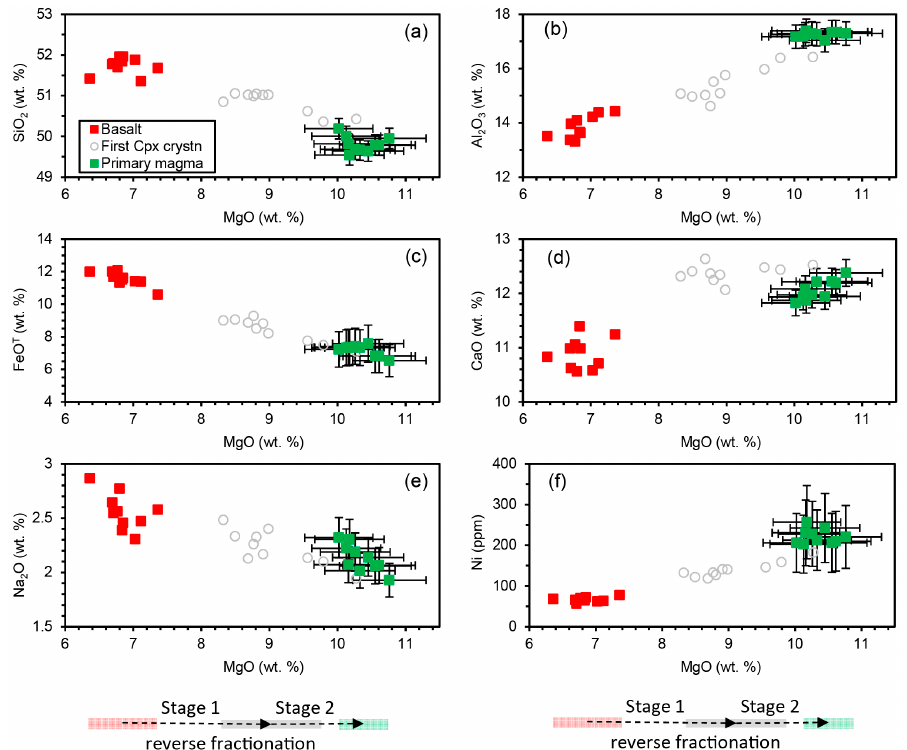
Figure 7. Bivariate plots showing the variation of the major oxides ( a – e ) and Ni with MgO ( f ) for the Rajmahal Group I basalts (corrected melt compositions) and their primary magmas. The compositions of melt in which clinopyroxene first crystallizes (end of stage 1) are also plotted. The direction of reverse fractionation with increasing MgO is shown by arrows at the bottom. Table 5. P-T of crystallization and last equilibration of primary magma with mantle for the Rajmahal Group I